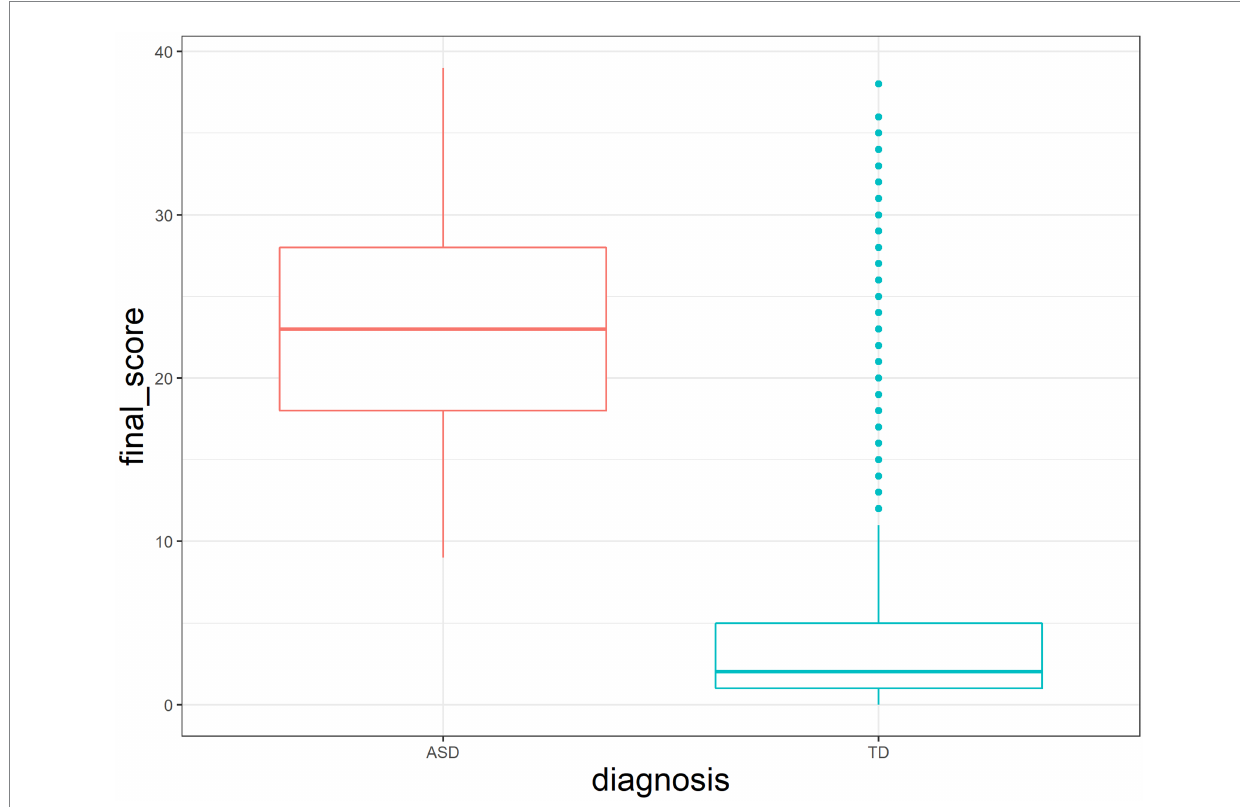
FIGURE 2 SCQ score distribution over the two samples [ASD and Sibs = “Typically Developing”